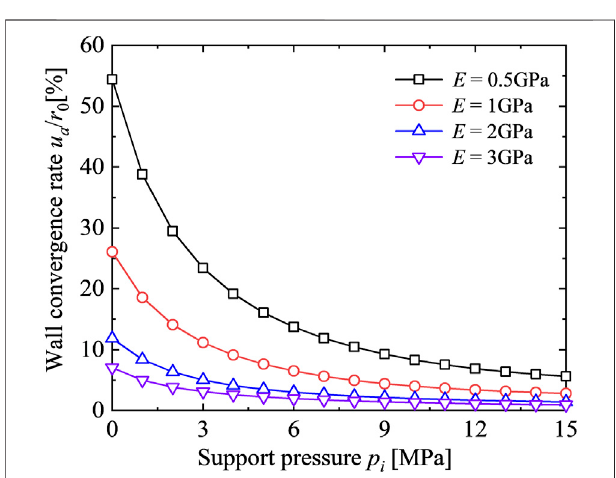
FIGURE 7 | In fl uence of the annulus number.